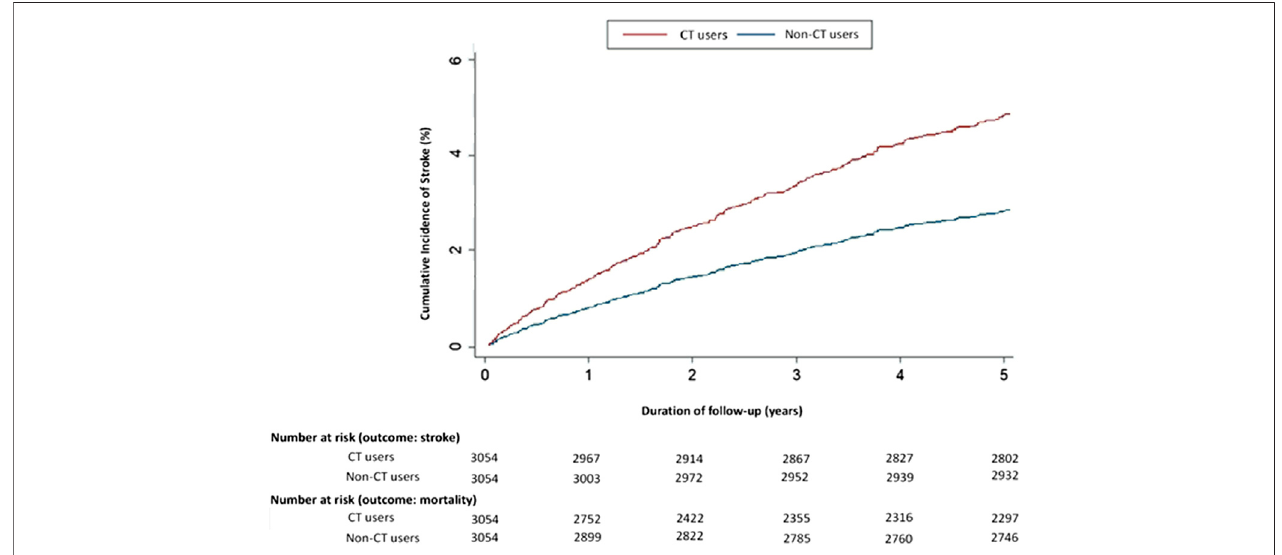
FIGURE 2 | Cumulative incidence rates of stroke in 2000 – 2006 differed signi fi cantly in adjusted Kaplan-Meier estimates for cancer patients administered chemotherapy and those who were not. Abbreviations: CT, chemotherapy.